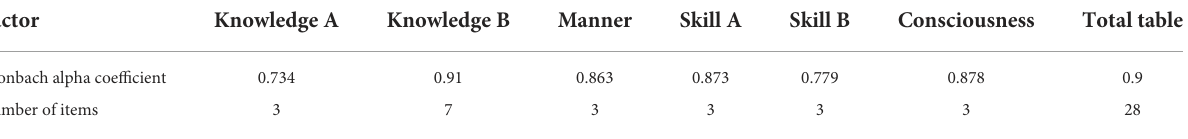
TABLE 2 Test results.